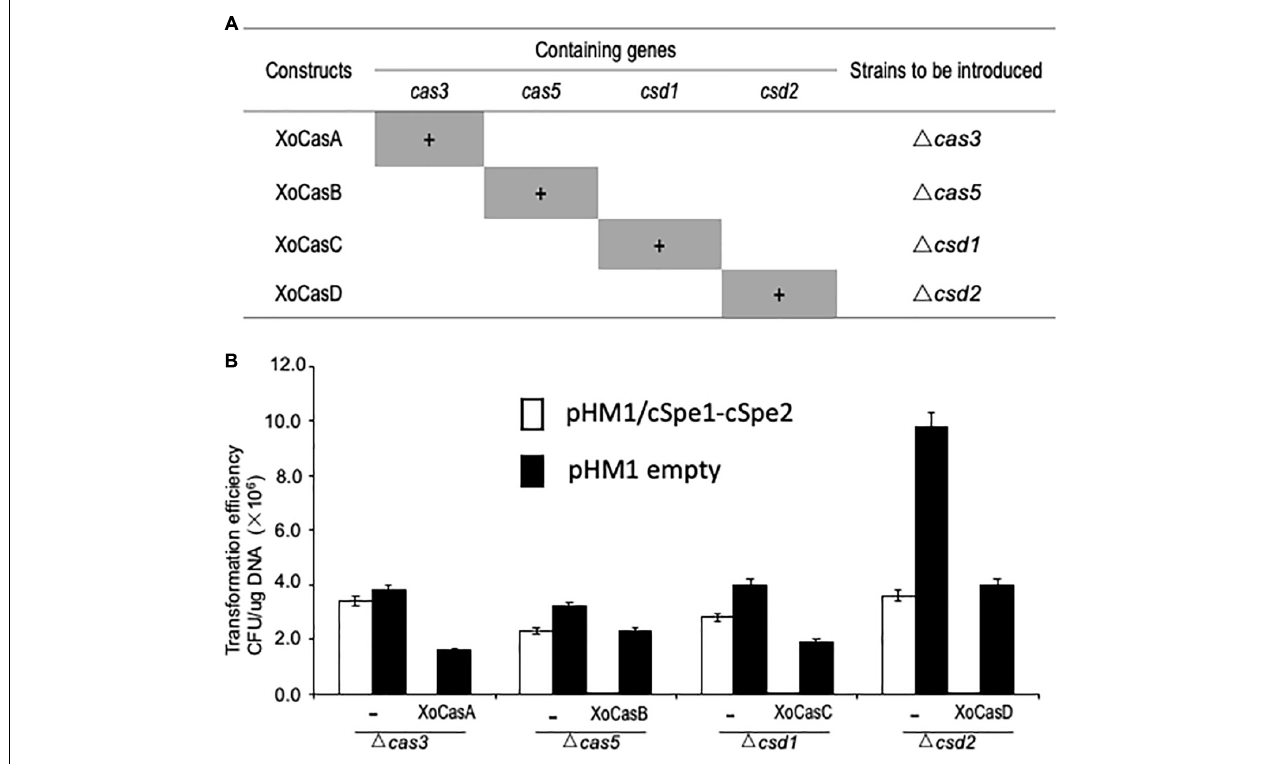
FIGURE 4 | Restored CRISPR activity in Cas gene complementing strains. (A) Constructs used to transform Cas gene mutant strains. Genes present in each construction are shaded in grey. (B) CRISPR function was restored in the complementing strains. Competent cells of the Cas gene knockout strain with or without ( – ) corresponding complementary construct were used to test CRISPR activity by introducing gRNA targeting the spectinomycin resistance gene in the pHM1